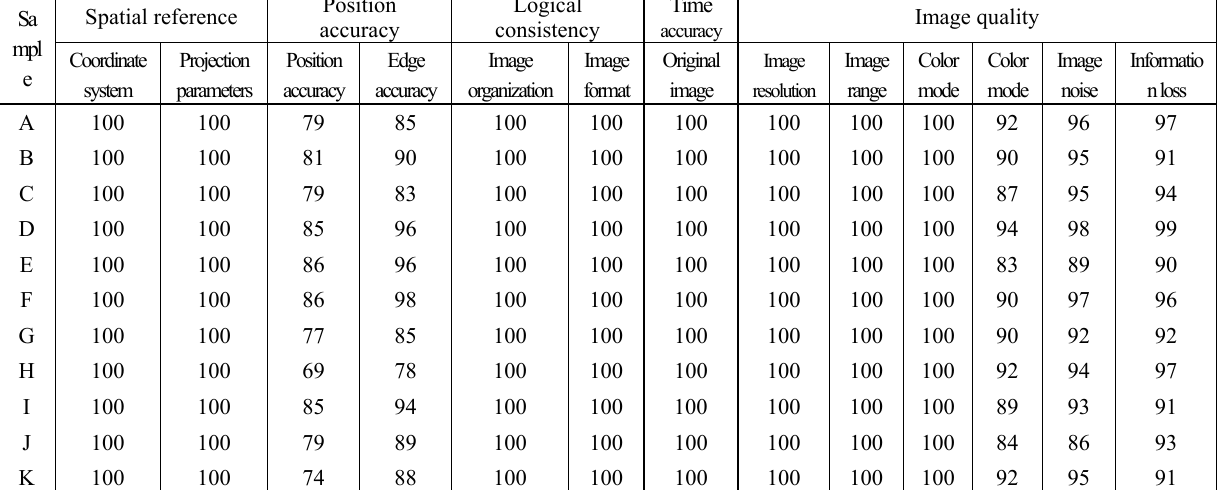
Table 5. Partial inspection results of the third national land survey satellite orthophotos quality (Anhui Province) Fuzzy Sample